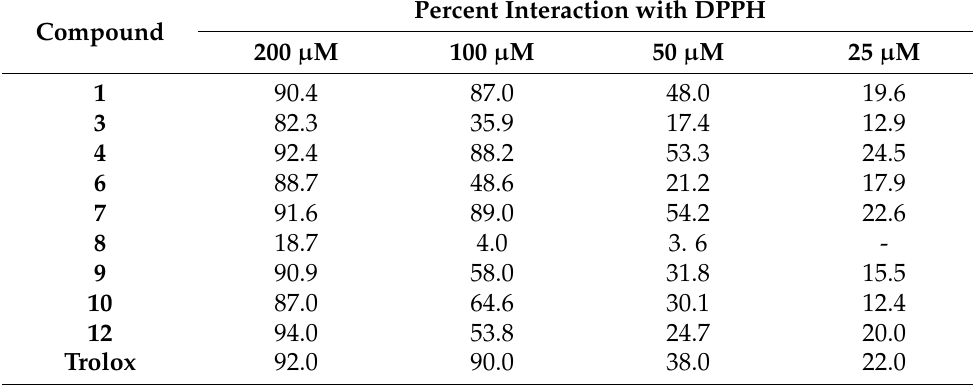
Table 2. Interaction of compounds 1 , 3 , 4 , 6 , 7 , 8 , 9 , 10 , 12 and Trolox at various concentrations, with DPPH (200 µ M) a